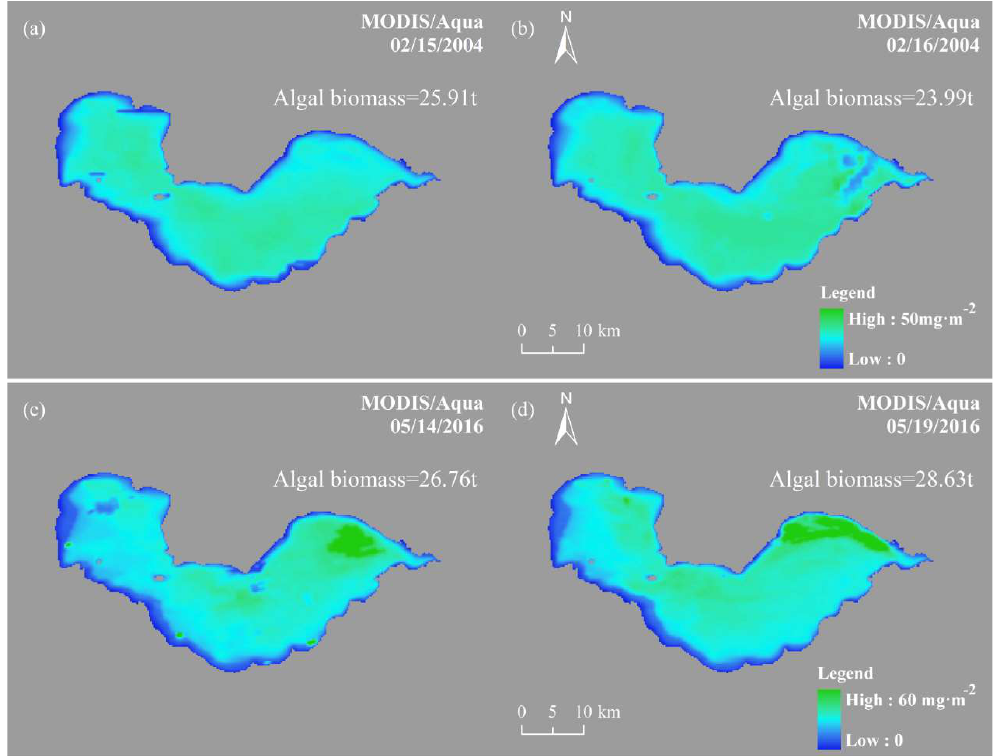
Figure 7. Area integrated validation results based on satellite images. Estimated algal biomass results from MODIS observation in consecutive days: ( a ) on 15 February 2004 ( b ) on 16 February 2004. The variation between ( a , b ) is 1.08 t with MAPE = 7.41%. Comparison of MODIS derived algal biomass in the adjacent day: ( c ) on 15 May 2016 ( d ) on 19 May 2016. The variation is 1.87 t, MAPE = 7.41%.